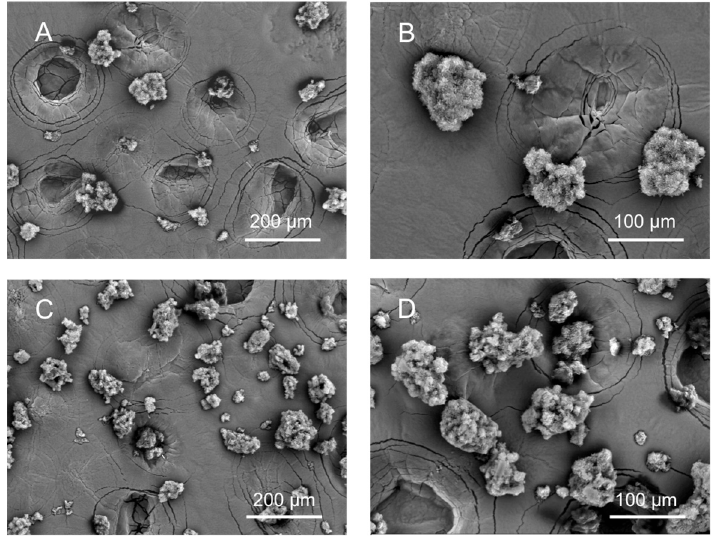
Figure 2. Scanning electron microscopy (SEM) images of ( A , B ) GMS-LID0 and ( C , D ) GMS-LID4 particles. The processing of GMS with LID did not influence the overall appearance and shape of the particles.